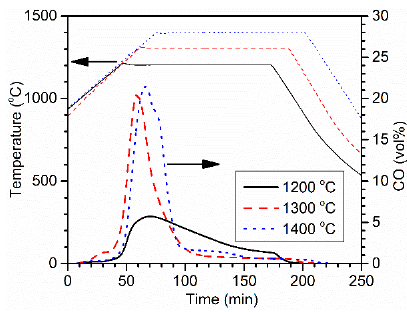
Figure 7. Temperature profiles and off-gas CO concentrations for the tests at different temperatures.